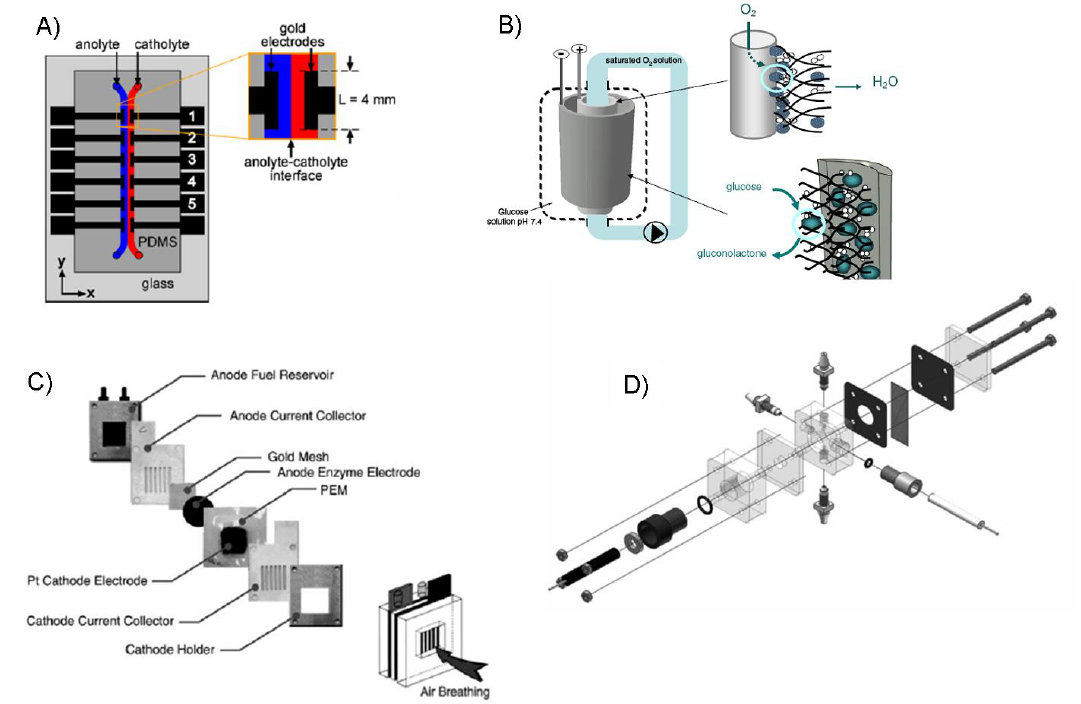
Figure 14. Schematic presentation of (A) microfluidic biofuel cell device; (B) concentric biofuel cell; (C) miniature biofuel cell consisting of an enzymatic anode and an air-breathing Pt cathode; (D) standardized modular stack cell platform. (A) and (B) reprinted from [101] and [76] with permission from Elsevier. (C) and D) reprinted from [27] and [103]. Copyright Wiley-VCH Verlag GmbH & Co.